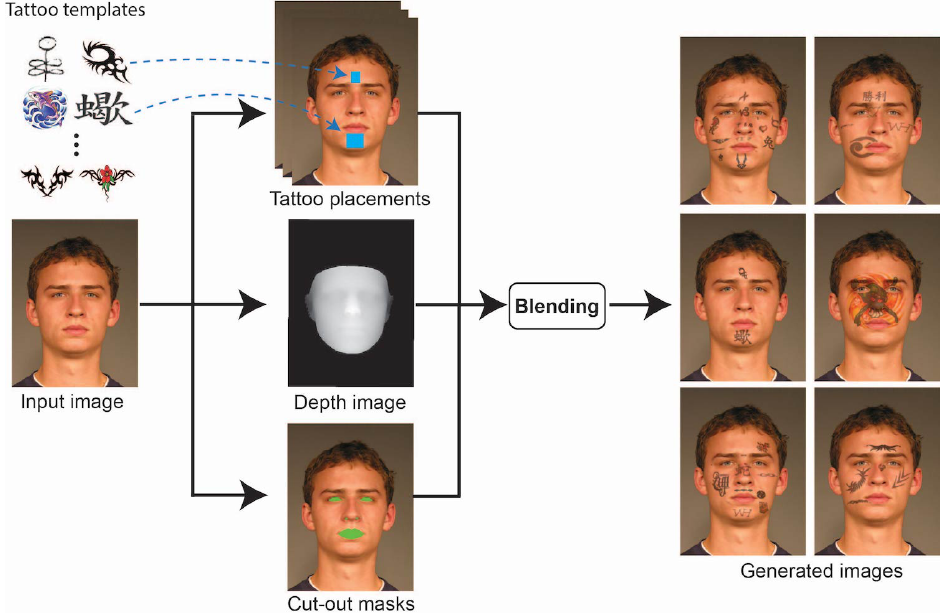
Figure 2. Synthetic facial tattoo generation workflow.